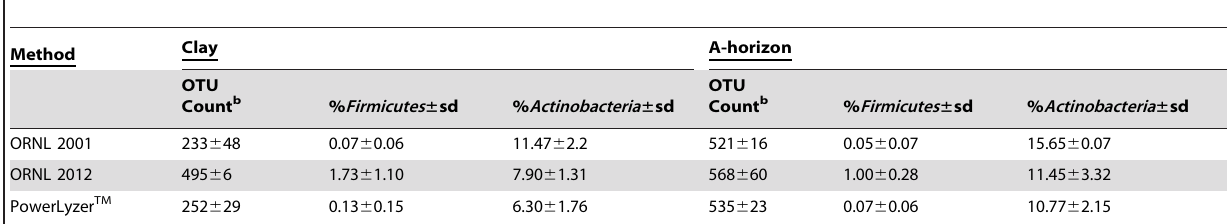
Table 1. Comparison of Methods by OTU Counts a percentage of OTUs from Dominantly Gram Positive Phyla.